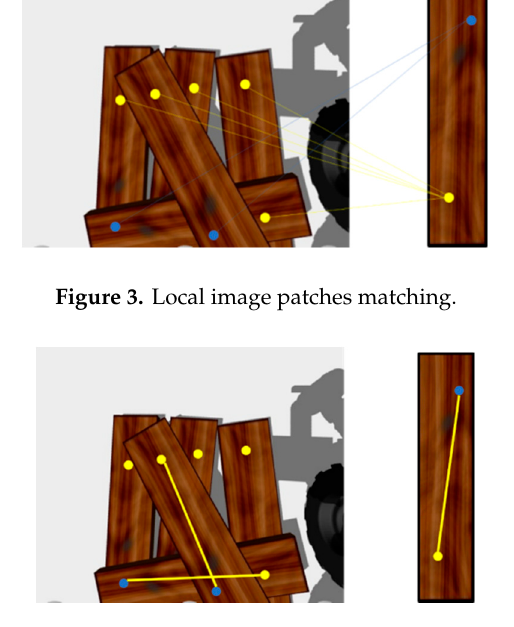
Figure 4. Local image patches of paired relation.